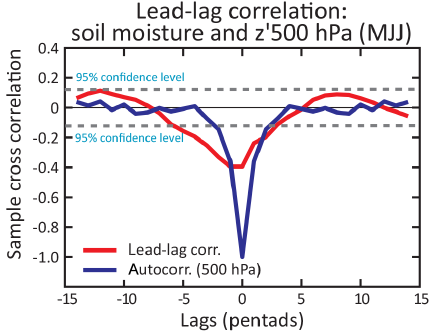
Figure 8. The possibility that soil moisture anomalies can affect the character of the overlying atmospheric circulation could have profound implications for our understanding of drought evolution and maintenance. The plot above shows the statistical connection between soil moisture (as derived from offline land analyses) and 500hPa geopotential height anomalies (as derived from an atmo- spheric reanalysis). More specifically, the red curve shows the lead– lag correlation between pentad soil moisture anomalies and the height anomalies during May–July (MJJ) over the south-central United States over the period 1981–2012, whereas the blue line depicts the autocorrelation function (ACF) of the pentad 500 hPa geopotential height anomalies of MJJ for the same region and pe- riod. The ACF values have been multiplied by − 1 for easy compar- ison with the red curve. The 95% confidence bounds are derived as the standard deviations divided by the square roots of N , where N is the effective number of independent samples. (The original sample size is n = 612, whereas N = 139 after accounting for au- tocorrelation in the time series.) The fact that the red curve lies be- low the blue curve (and is significant) for − 1 to − 6 pentads indi- cates that positive large-scale midtropospheric geopotential height anomalies (which are characteristic of circulation patterns associ- ated with drought) are more correlated with soil moisture deficits 5– 30 days earlier than they are with earlier height anomalies, suggest- ing that the patterns may be influenced more by soil moisture than by the memory of the large-scale atmospheric circulation (either remotely forced by sea surface temperature anomalies (SSTAs) or through memory provided by the internal atmospheric variability). This result provides observational evidence of soil moisture feed- back on large-scale drought circulation in summer over the south- central US (or southern plains). (Contact: Rong Fu. Figure taken from Fernando et al. (2016); see this reference for more informa-